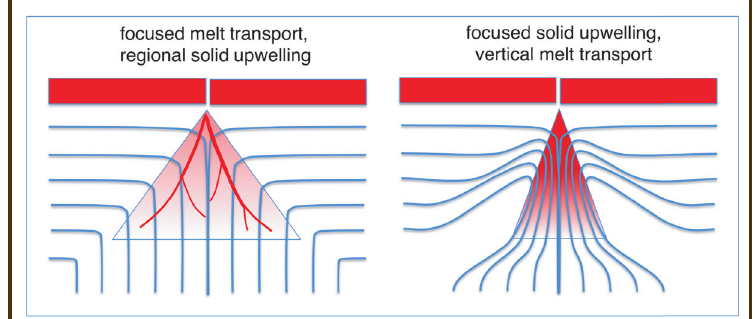
Figure 2. The magmas from which oceanic crust crystallizes form via partial melting of the mantle as it rises and decompresses beneath spreading centers, driven by the divergence of the tectonic plates. The mechanism that drives focusing of the partial melts to form igneous oceanic crust over a narrow region (just a few kilometers wide at the spreading center) is not well understood. Is this due to focused melt transport coalescing within a wide region of solid mantle upwelling, or a result of highly focused solid upwelling? Study of melt transport veins and solid deformation structures in the mantle portions of the Oman ophiolite can resolve this